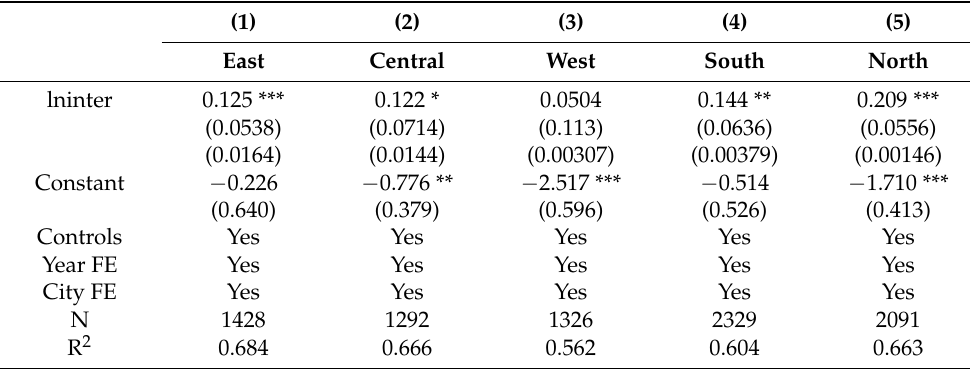
Table 7. The impact of geographic